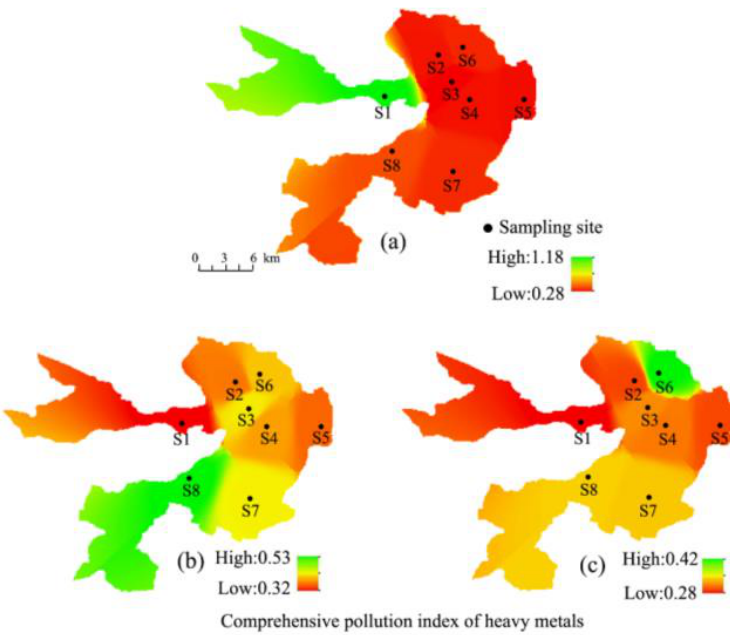
Figure 4. Comprehensive pollution index in the spring ( a ), summer ( b ), and autumn ( c ). Table 8. Comprehensive pollution index of heavy metals in Baiyangdian river